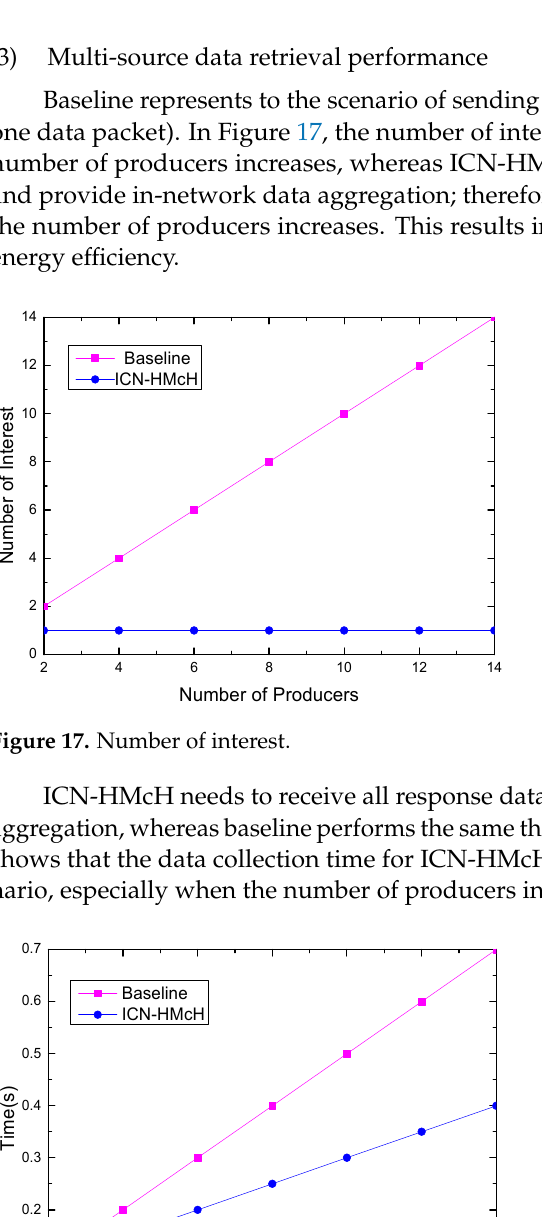
Figure 16. Delay variation for two structured packets.